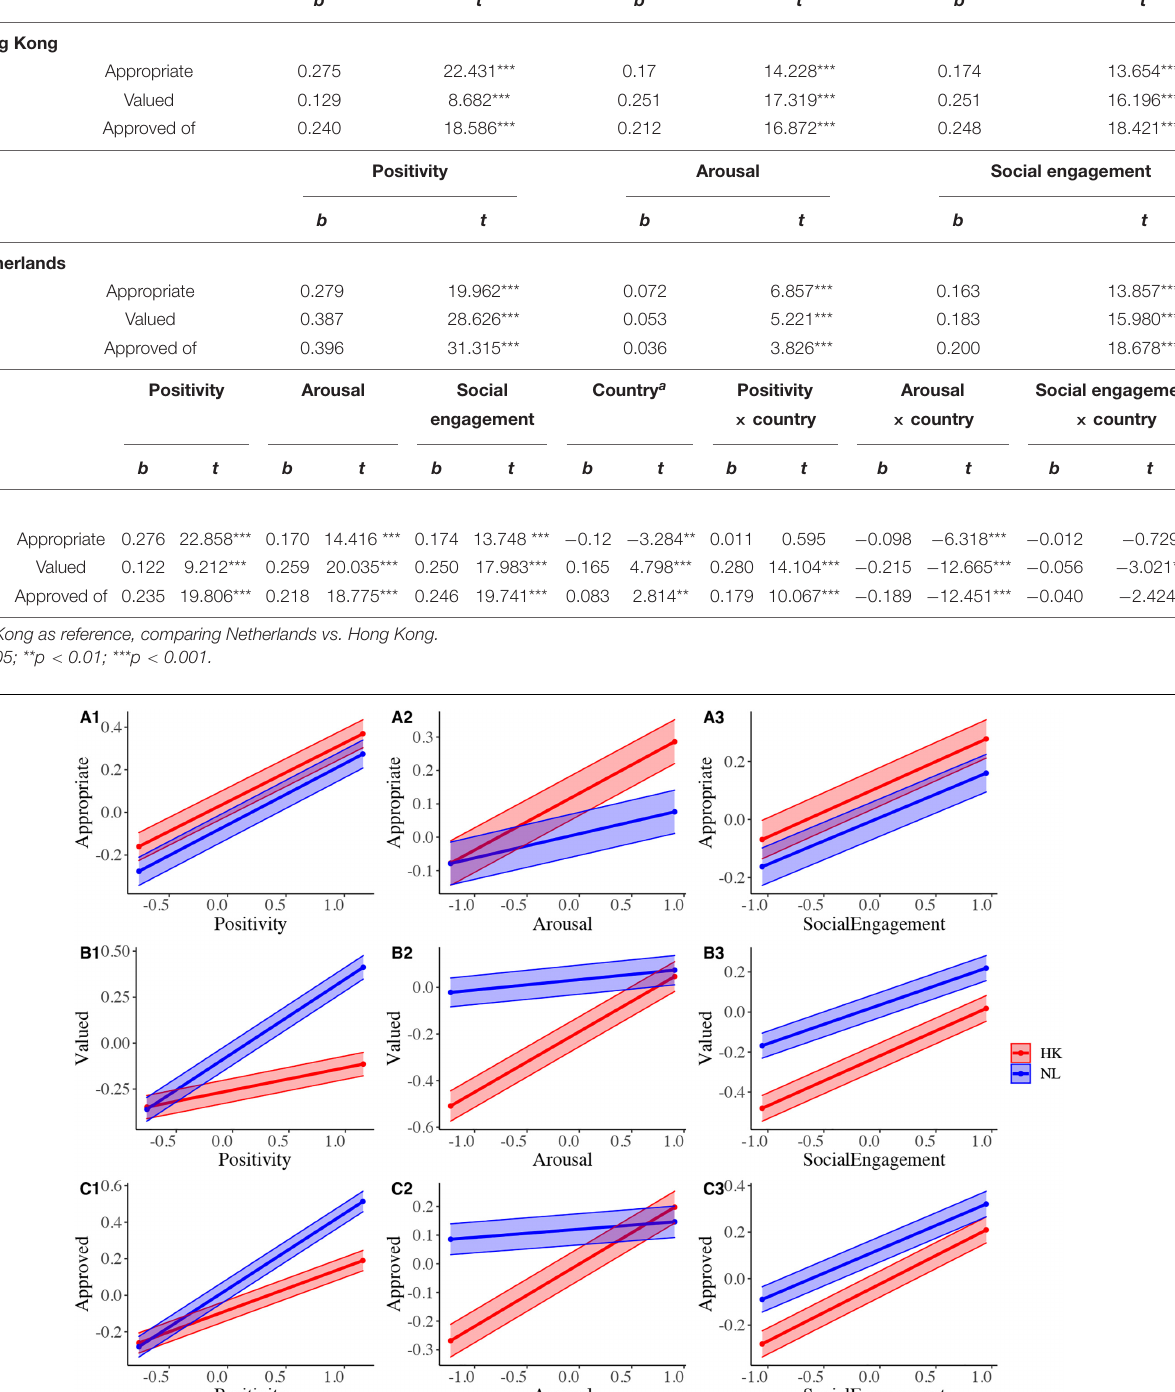
TABLE 1 | Multilevel regression models of associations between individual evaluations and societal evaluations (A,B) , and cultural differences between Hong Kong and Netherlands in the emotion perception–evaluation link of 23 positive emotions (C) . Positivity Arousal Social engagement